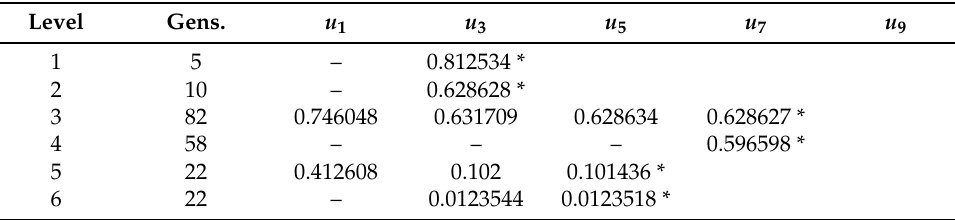
Table 2. Upper bounds for the j -reliability of the consecutive k -out-of- n system in Example 6.